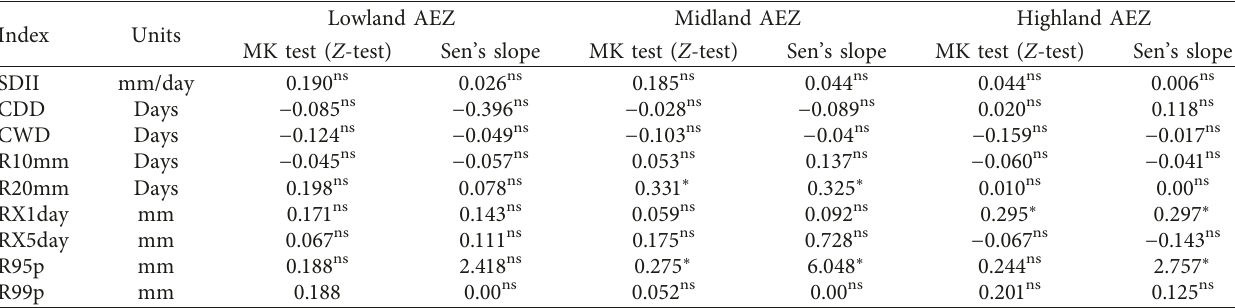
Figure 7: Trend of the simple daily intensity index (SDII) over three agroecological zones, (a) lowland, (b) midland, and (c) highland, for the period 1983–2014. Table 4: Trends in precipitation extreme indices per year by